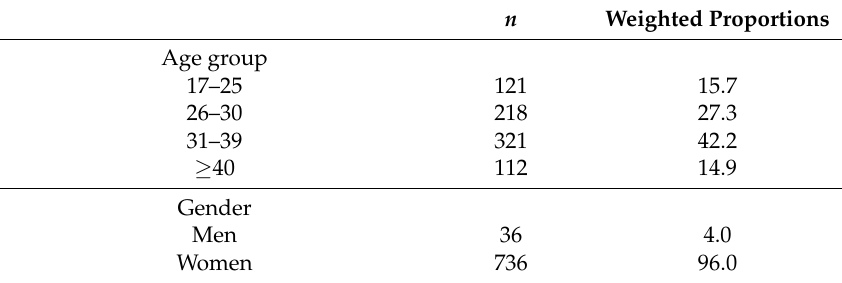
Table 1. Characteristics of the